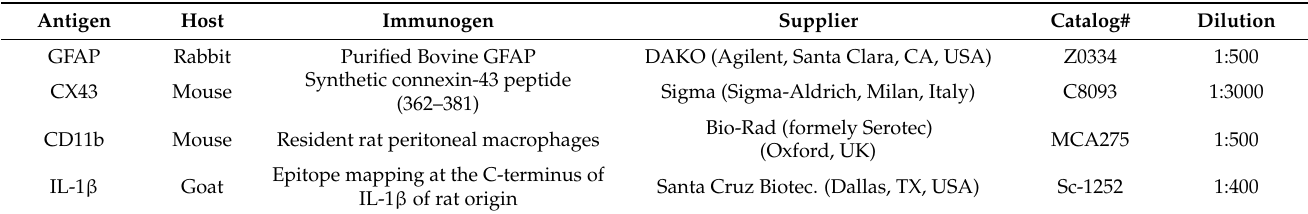
Table 4. Antibodies used in this